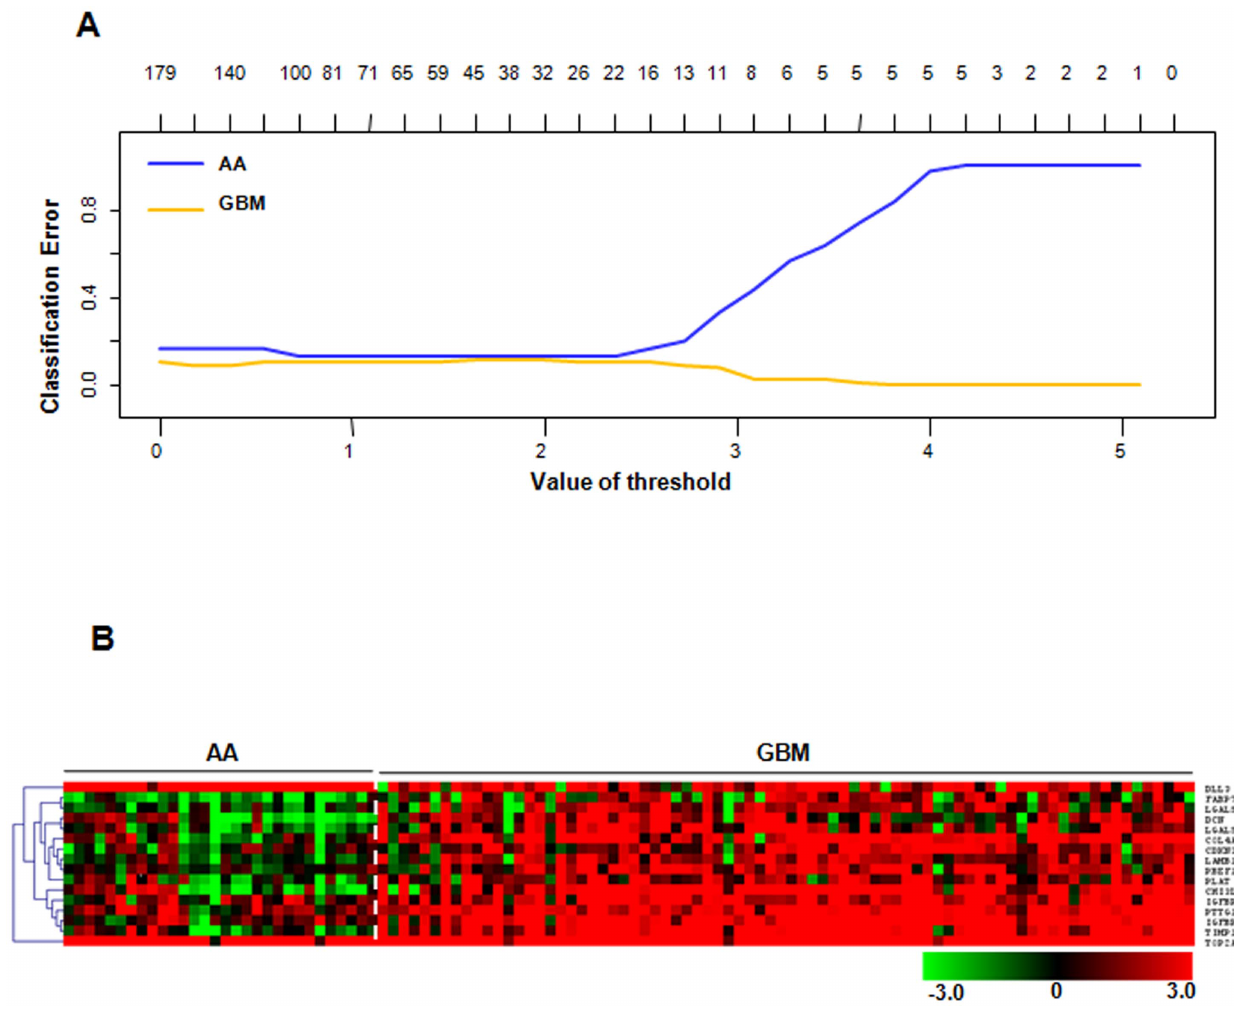
Figure 2. Identification of 16-gene signature in training set. A. Plot showing classification error for the 175 input genes from PAM analysis in the training set. The threshold value of 2.5 corresponded to 16 genes which classified AA (n=30) and GBM (n=78) samples with classification error of 0.12. B. Heat map of one-way hierarchical clustering of 16 PAM-identified genes in AA and GBM patient samples of the training set. A dual-color code was used, with red and green indicating up- and down regulation,